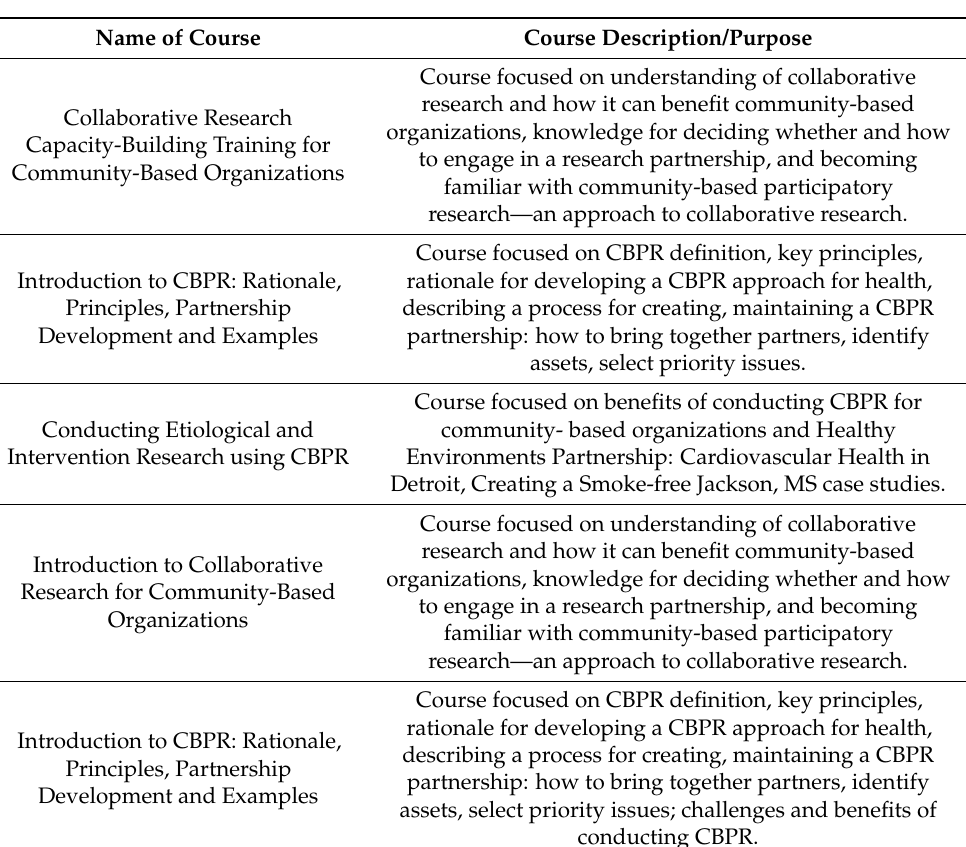
Table 3. Jackson State University Jackson Heart Study (JHS) Community Outreach Center (CORC) Trainings